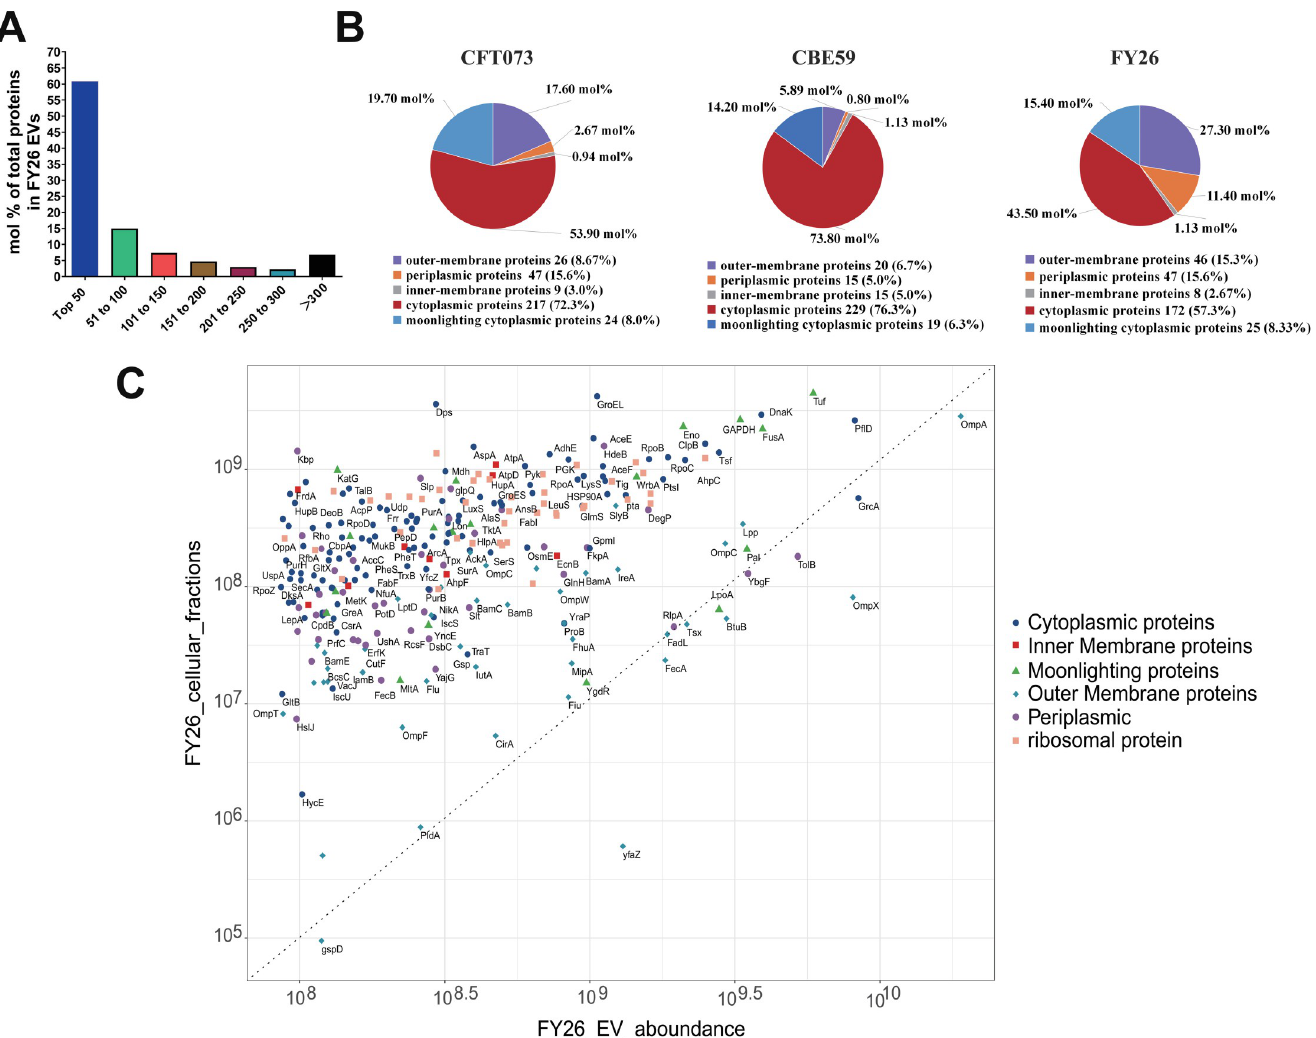
Fig 3. Quantification and bioinformatic analysis of the proteins enriched in ExPEC EVs. (A) Abundances of the 300 most-abundant proteins of FY26 EVs relative to the total protein. The horizontal axis indicates 50 proteins sorted by abundance from most to least abundant relative to the total protein abundance, and the vertical axis indicates the protein abundance relative to the total protein. (B) Subcellular localization classification of the 300 most-abundant proteins identified in EVs from different ExPEC strains (FY26, CBE59, and CFT073). Subcellular localization of the identified proteins was determined with CELLO (http://cello.life.nctu.edu.tw). The numbers of the proteins are displayed below the pie chart, and the percentage abundances are shown in the pie chart. (C) The 300 most-abundant proteins isolated from the FY26 EV fractions were compared with their abundances in the total FY26 cellular fractions. Subcellular localization is shown as follows: outer-membrane proteins (light blue), periplasmic proteins (purple), inner-membrane proteins (red), cytoplasmic proteins (deep blue), moonlighting proteins (green), and ribosomal subunit proteins (orange). Proteins enriched in the FY26 EVs are shown below and to the right of the dashed line, and proteins depleted in the EVs are shown above and to the left of the line. The data for this figure can be found in S1